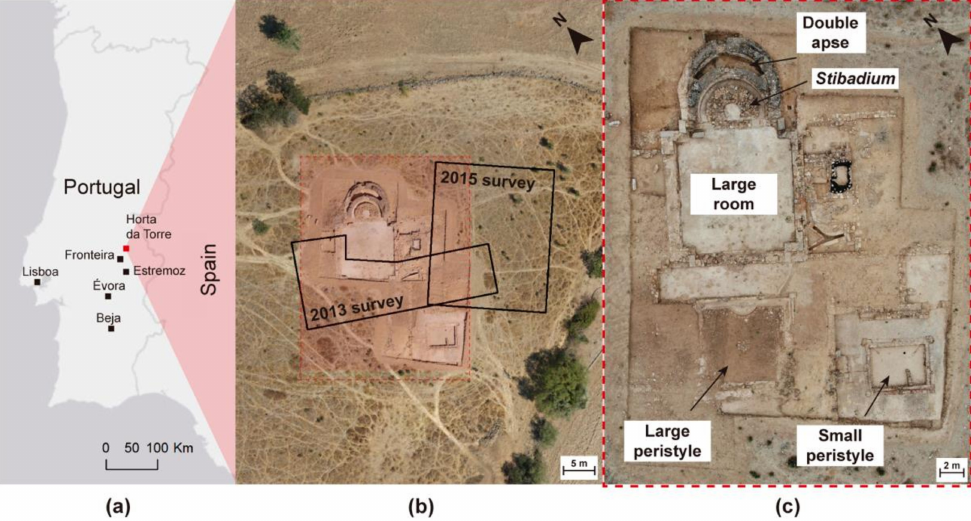
Figure 1. ( a ) Geographical location of Horta da Torre. ( b ) General overview of the archaeological site and representation of the GPR surveys performed in 2013 and 2015. ( c ) Orthophoto of Horta da Torre remains taken in 2019, showing the status of the